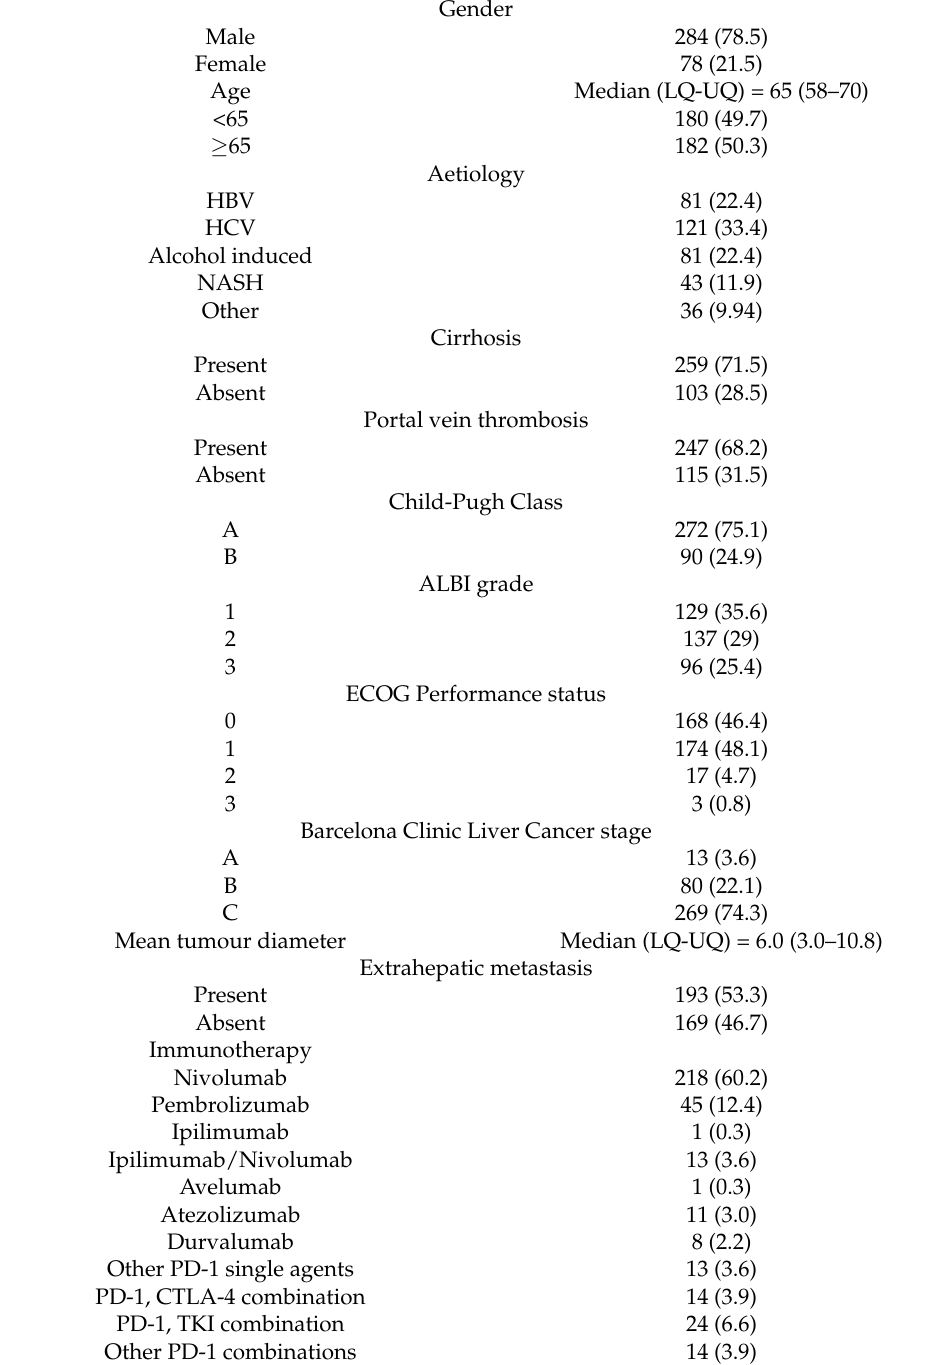
Table 1. Clinicopathological features at